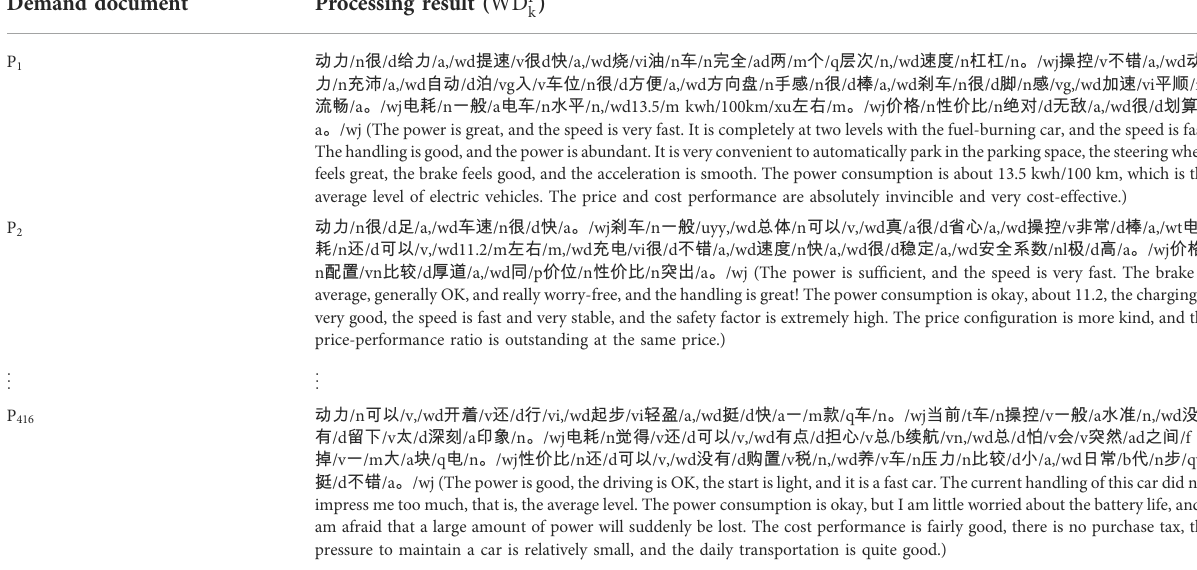
TABLE 7 Extracted demand attributes based on LDA.